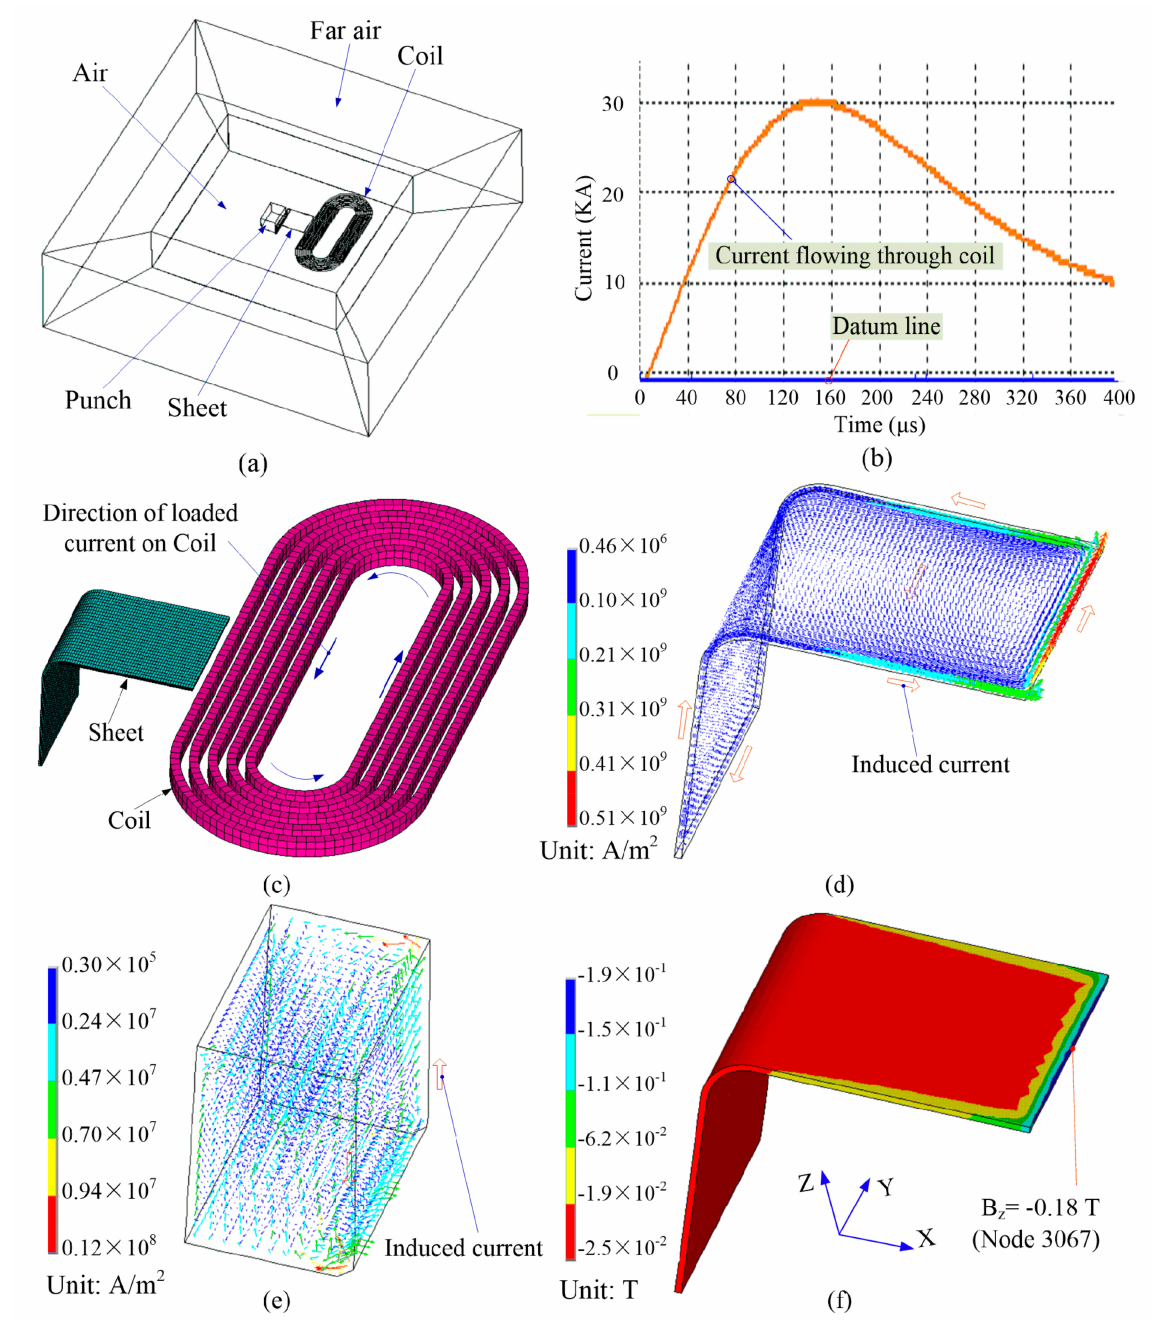
Figure 6. Electromagnetic field analysis: ( a ) 3D model, ( b ) measured current, ( c ) meshes of sheet and coil, ( d ) induced current on sheet, ( e ) induced current on punch, and ( f ) magnetic flux density on